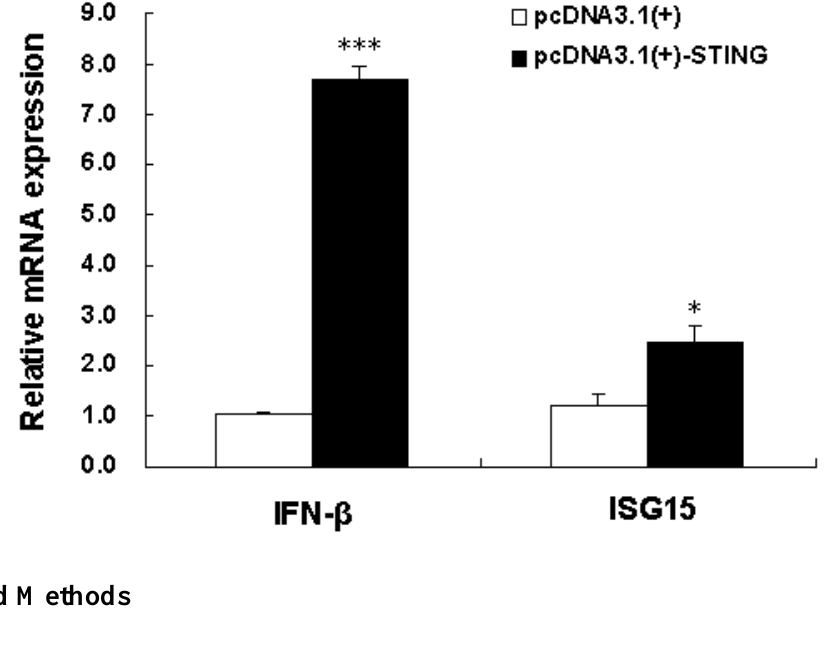
Figure 3. Overexpression of Tibetan porcine STING leads to upregulation of IFN-β and ISG15. IPEC-J2 cells were transfected with 2 µg/well of the plasmid pcDNA3.1(+)-STING or the empty vector pcDNA3.1(+). IFN-β and ISG15 mRNA levels were determined using real-time quantitative PCR 24 h after transfection. The amount of IFN-β and ISG15 mRNA was normalized to the amount of β-actin mRNA. Results are the mean and standard errors from three independent experiments performed in duplicate. * P < 0.05 and *** P < 0.001 as compared with empty